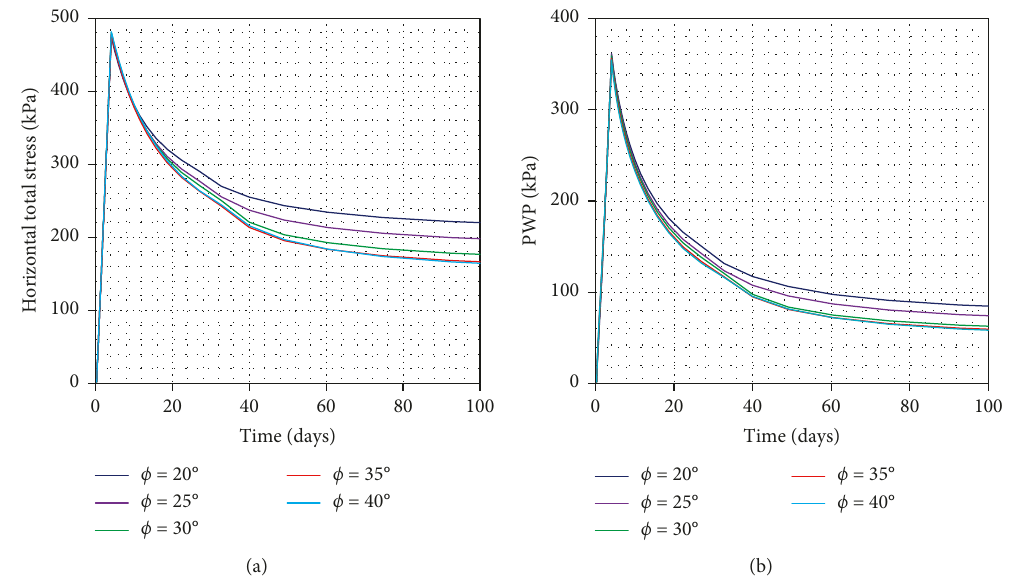
Figure 11: Evolution of the (a) horizontal total stress σ h and (b) PWP u w at midheight of the barricade for five different values of the backfill frictional angle (see the details in Table 1, Case